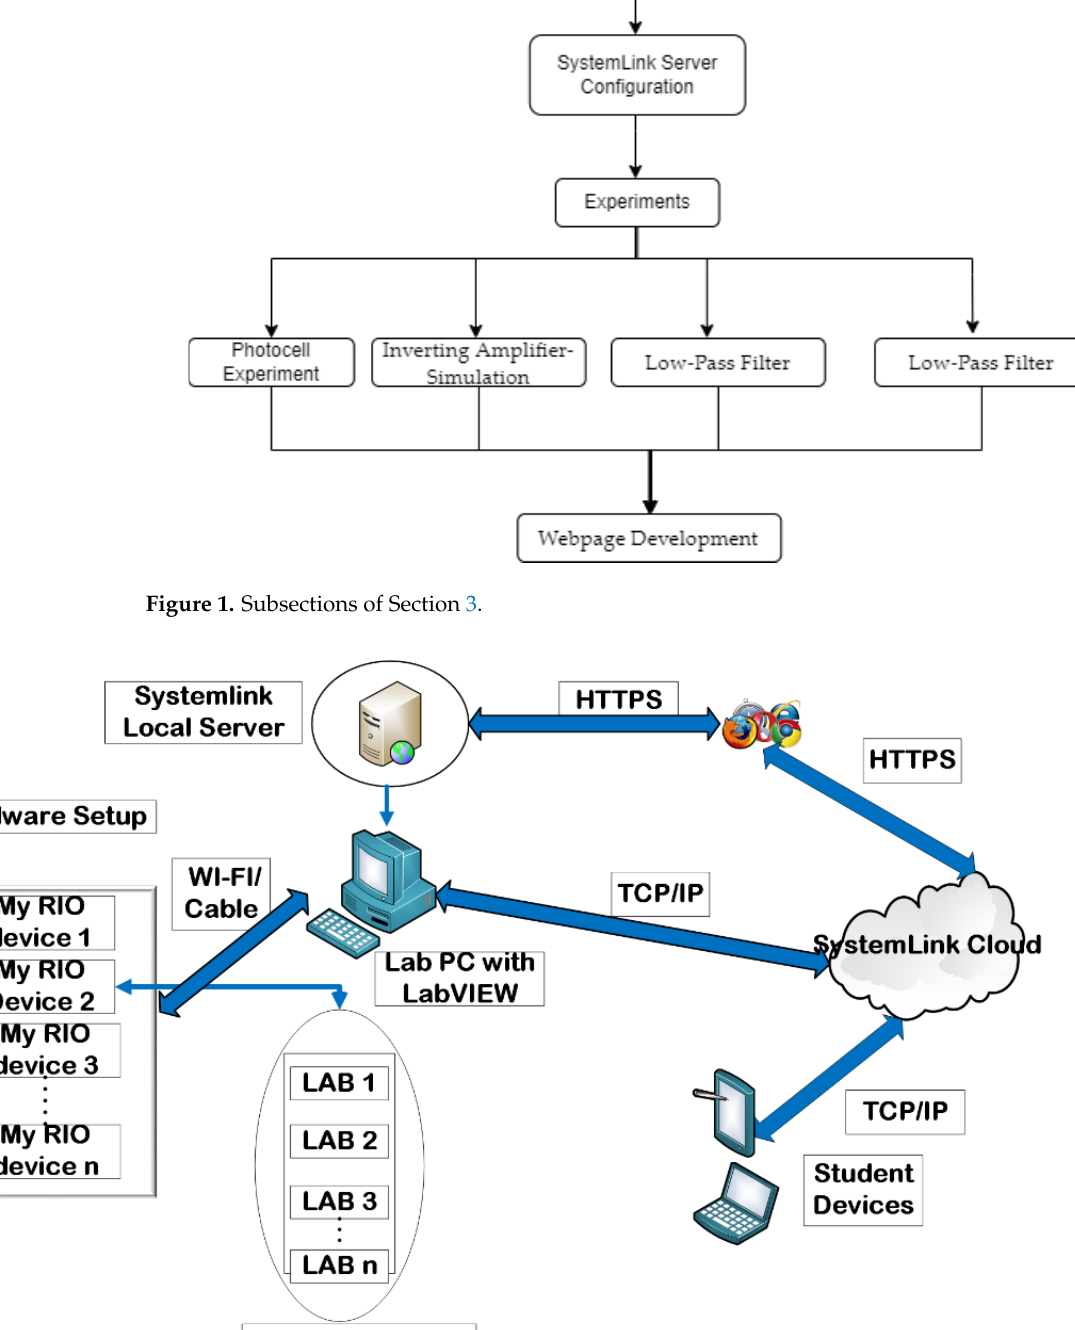
Figure 1. Subsections of Section 3.